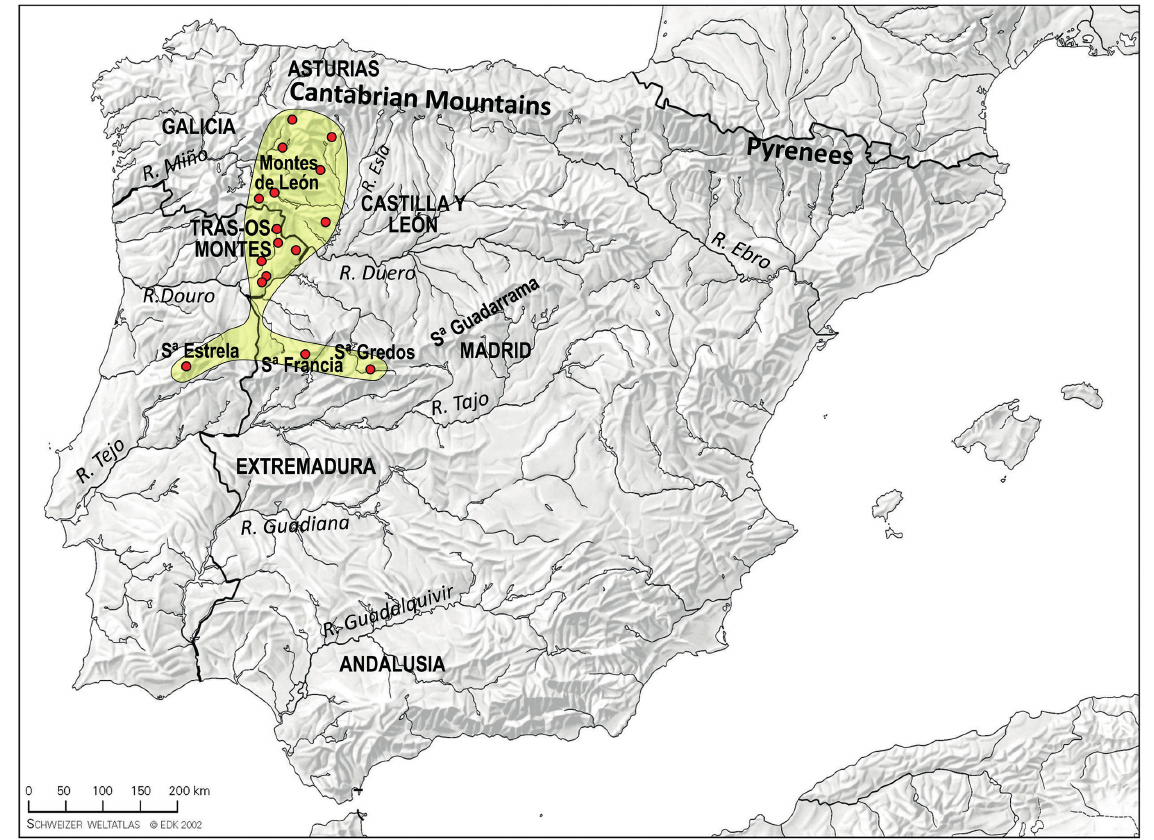
Fig. 8. Geographical distribution of Leiolima iberica gen. et sp. nov. on the Iberian Peninsula. Some names of autonomic or regional entities (in capitals, without borders), mountain ranges and larger rivers (in italics) are